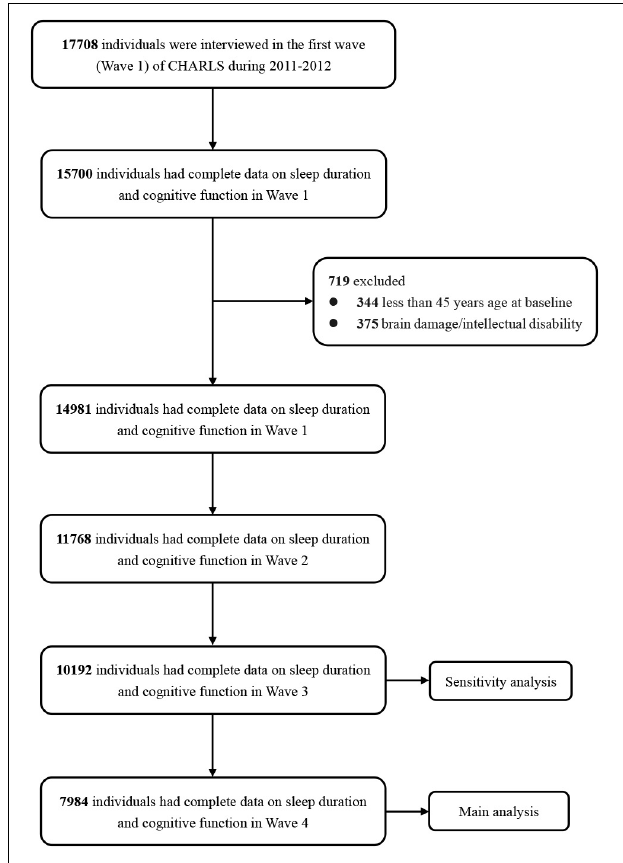
FIGURE 1 | Flowchart of participant